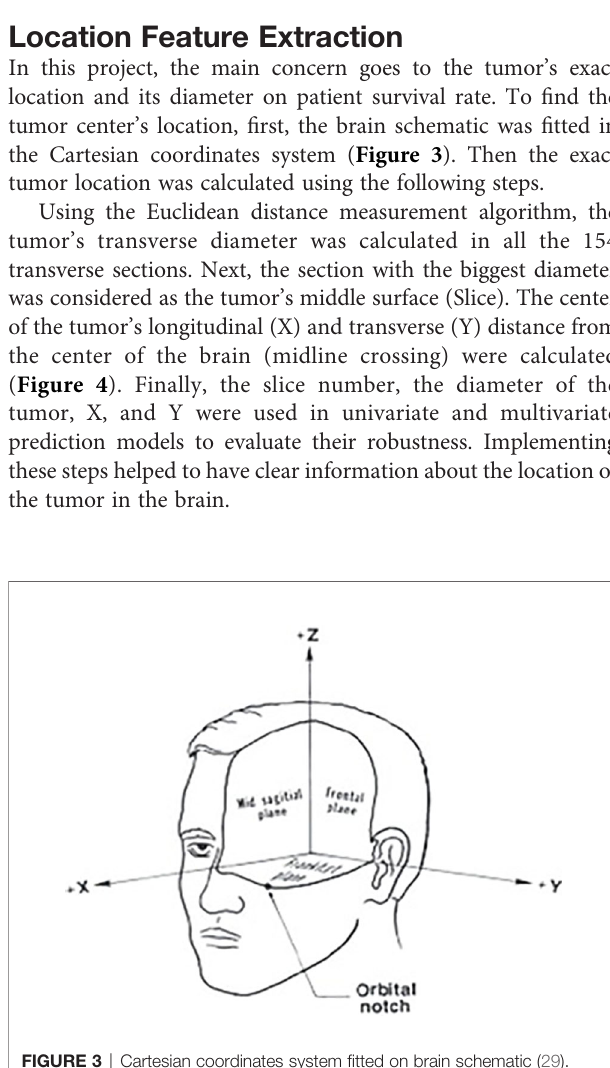
FIGURE 3 | Cartesian coordinates system fi tted on brain schematic (29). FIGURE 4 | Longitudinal and transverse distance